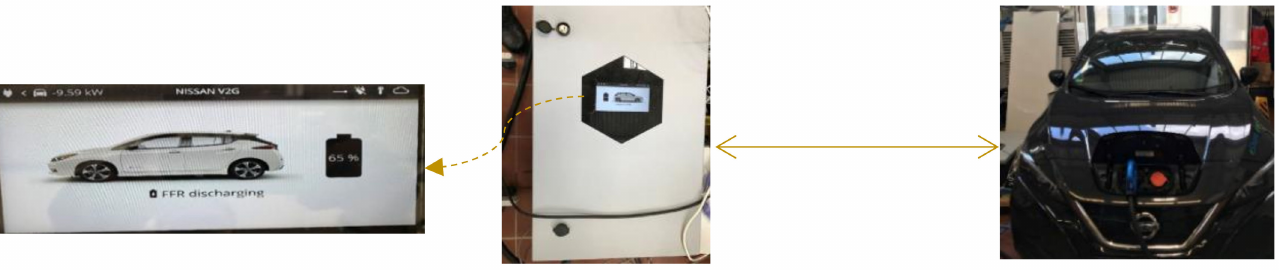
Figure 15. E.ON Essen test